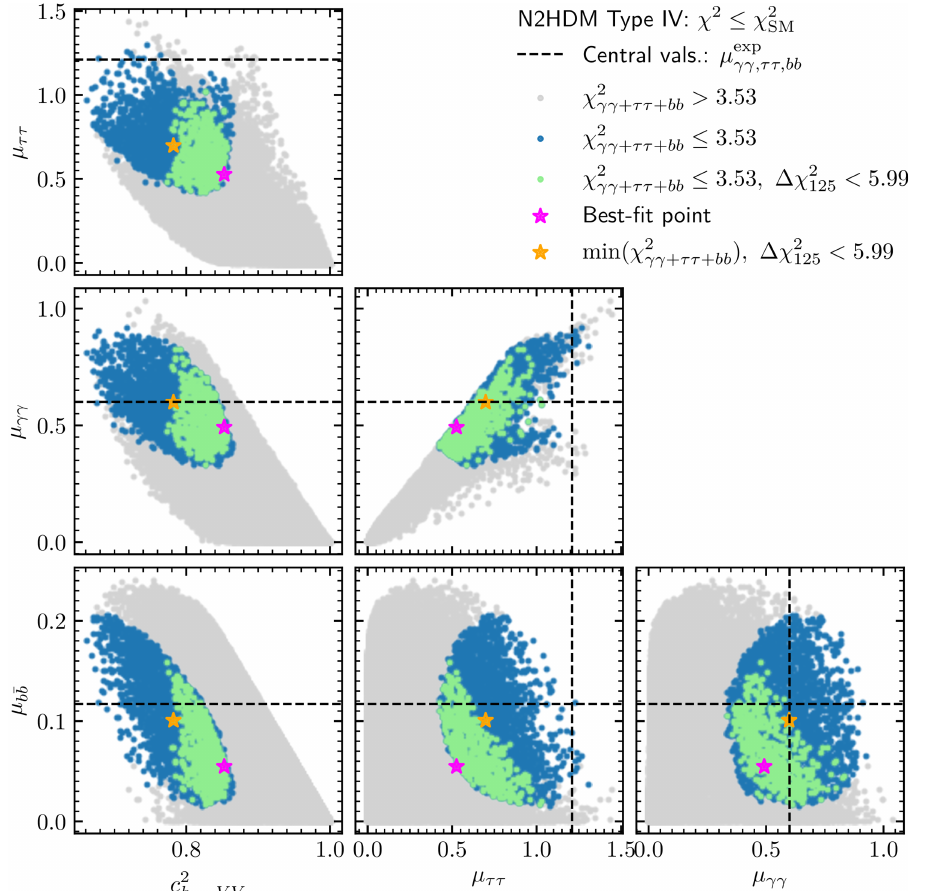
Figure 4 . Correlations between the signal rates µ ττ , µ γγ and µ c 2 . Parameter points that fit the excesses within a three-dimensional confidence level of 1 σ h 125 V V are shown in blue, whereas the remaining points are shown in grey. Green points fit the excesses within a confidence level of 1 σ and additionally fulfill the condition ∆ χ 2 point ( χ 2 = 90 . 86 , χ 2 = 87 . 40 ) is indicated with a magenta star. The orange star ( χ 2 = 92 . 66 , 125 χ 2 = 91 . 46 ) indicates the point with the minimal value of χ 2 125 ∆ χ 2 < 5 . 99 125